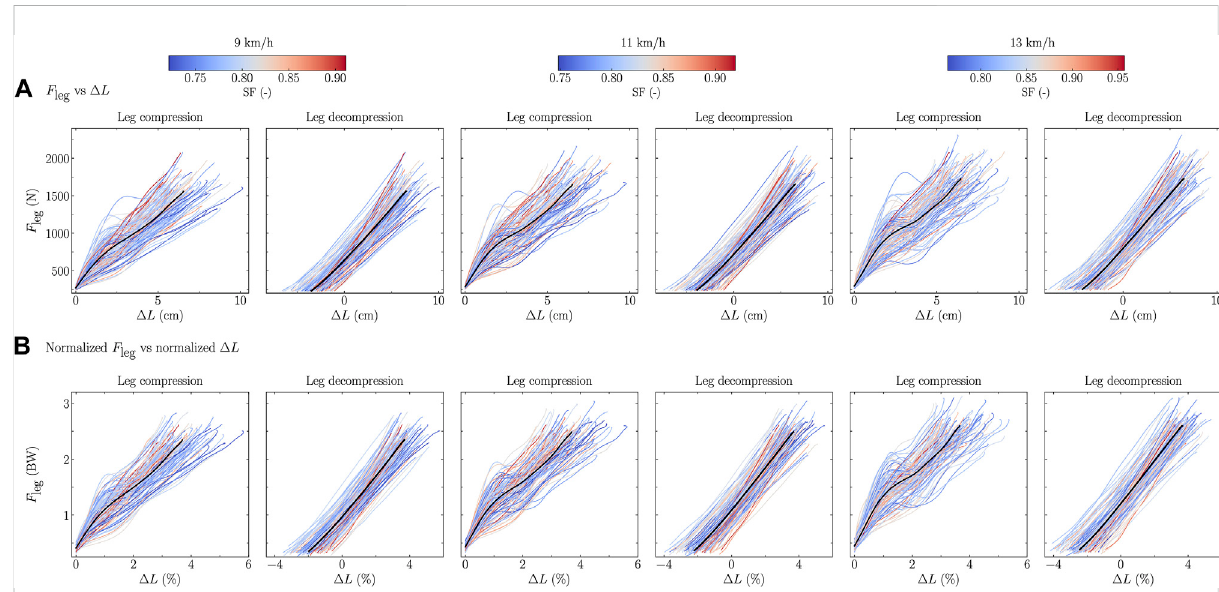
FIGURE 6 Force-lengthrelationship,i.e., groundreaction forceprojectedalong theleg( F leg )as functionofthelegcompression/decompression,for each participant [the color depends on the step frequency (SF) value; SF was normalized by length] and for the mean (black line) over all participants during the running stance phase, at three running speeds, and expressed using (A) SI units and (B) normalized units, i.e., body weight (BW) for F leg and percentage of runners ’ height for leg compression.